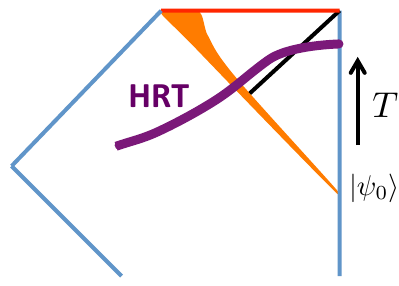
Figure 1 . Penrose diagram of a spacetime dual to a quench. Before the quench we have pure AdS, the infalling matter shell is colored orange, where the spacetime is strongly time dependent, and the spacetime subsequently settles to a static black brane. The horizon is a diagonal black line, the singularity is a red line, the Poincare horizon and the AdS boundary are drawn by blue, while the HRT surface computing the entropy of half space is a purple